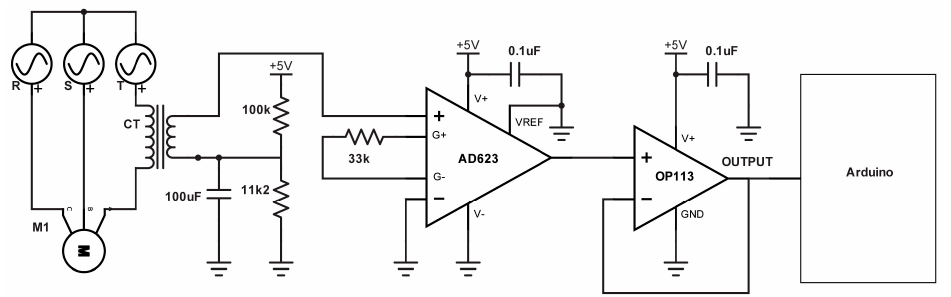
Figure 6. Signal conditioning circuit.